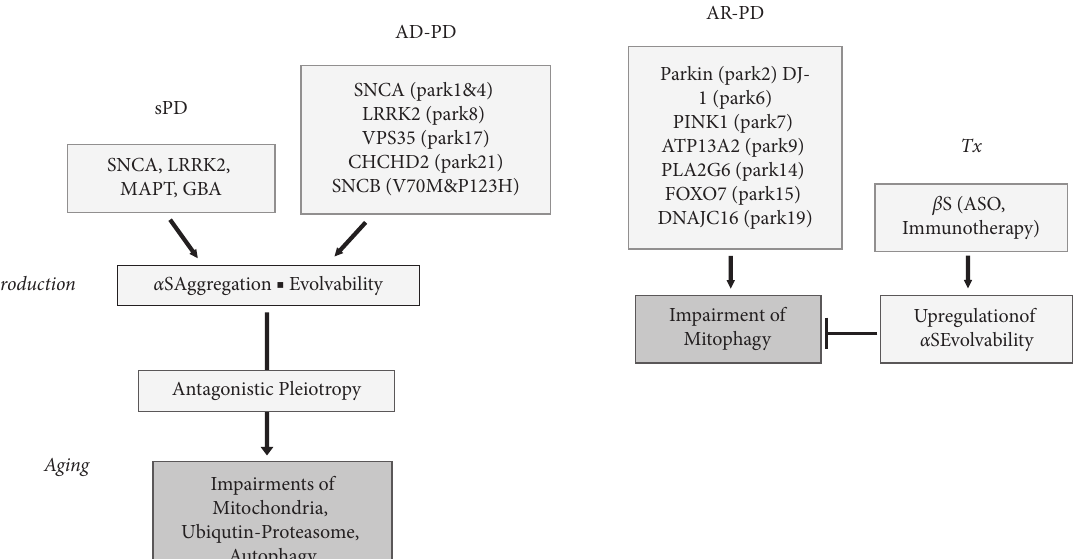
Figure 4: Illustration of the evolvability-based therapeutic strategy against autosomal recessive PD. The majority of PD is late-onset sPD associated with aggregation of a wild type α S. sPD might be caused by interaction of various genes, including SNCA, LRRK2, MAPT, and GBA, with environmental factors, such as trauma, pesticide, and hypoxia. In the reproductive stage, α S evolvability is beneficial for various cellular functions, such as mitochondria, lysosome-autophagy, and ubiquitin-proteasome system. However, these functions are later impaired through antagonistic pleiotropy, and the late-onset PD is manifested in aging. AD-PD is caused by missense mutations of the AD- PD genes, including SNCA (PARK 1 and 4), LRRK2 (PARK 8), VPS35 (PARK 17), and CHCHD2 (PARK 21) in addition to SNCB (V70 M and P123H). The neuropathology in AD-PD is similar to that of sPD and is characterized by aggregation of α S. On the other hand, AR-PD caused by missense mutations of the AD-PD genes, including Parkin (PARK 2), DJ-1 (PARK 6), PINK1 (PARK 7), ATP13A2 (PARK 9), PLA2G6 (PARK 14), FOXO7 (PARK 15), and DNAJC16 (PARK 19), and is associated with impairment of ubiqutin-proteasome, mi- tochondria, and autophagy, namely, mitophagy in the early-onset PD. Given the buffering effect of β S on α S evolvability, increase in α S evolvability through β S downregulation might be therapeutically beneficial in autosomal recessive PD. To achieve this, β S expression could be reduced by various methods, including ASO targeting β S mRNA and passive β S immunization therapy